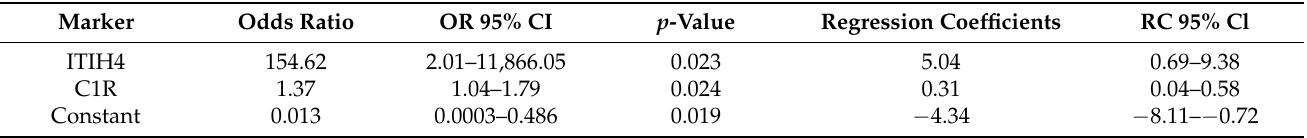
Table 3. Multivariate logistic regression model for EC biomarkers using exosome protein levels and resulting after step-down procedure. Only significantly associated variables are kept ( p <